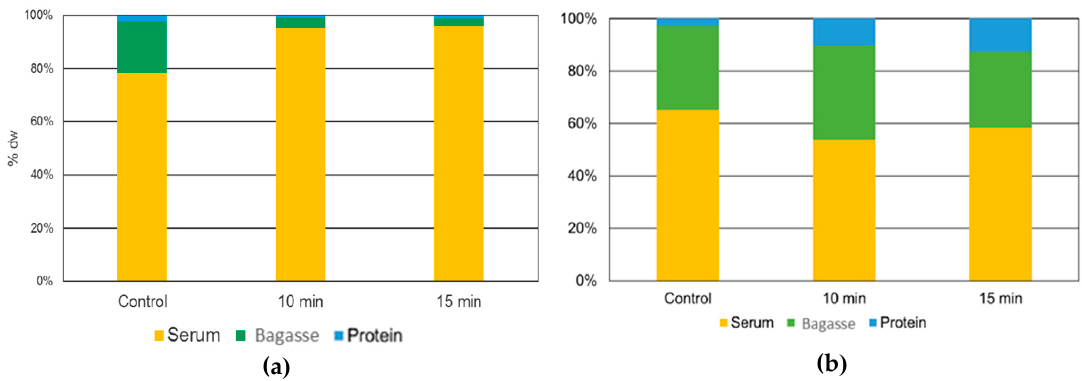
Figure 10. Quinolizidine alkaloids distribution in each fraction % of dry weight (serum, bagasse, and protein) obtained during US-assisted alkaline extraction and isoelectric precipitation from ( a ) L. mutabilis and ( b ) L. angustifolius .